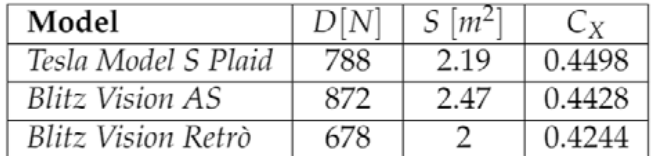
Figure 17. Numerical results of the CFD simulations.